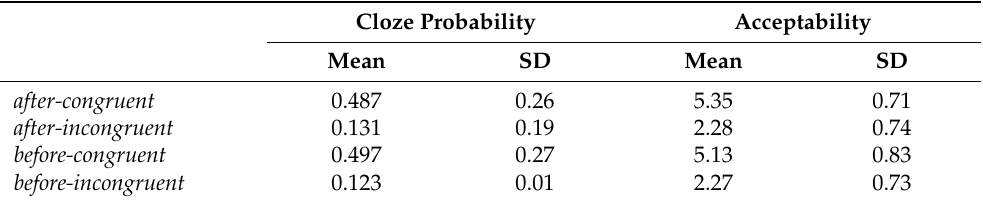
Table 3. Means and SD (standard deviations) of the experimental items.